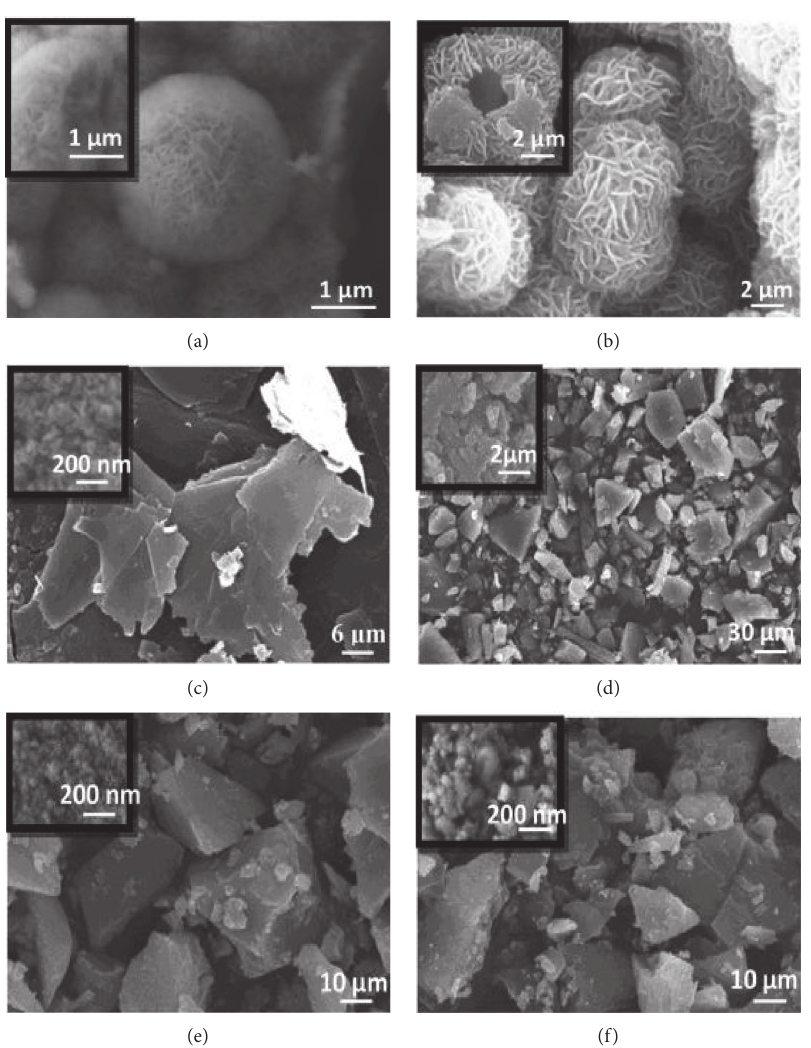
Figure 15: SEM micrographs of MoS 2 obtained from surfactant-assisted hydrothermal methods